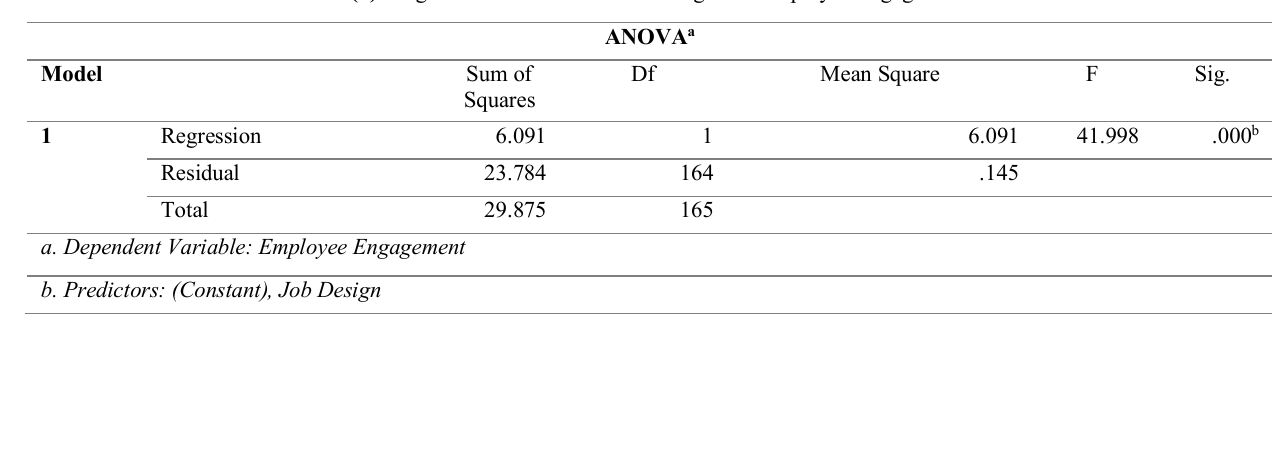
Table 3 (b): Regression ANOVA for Job Design and Employee